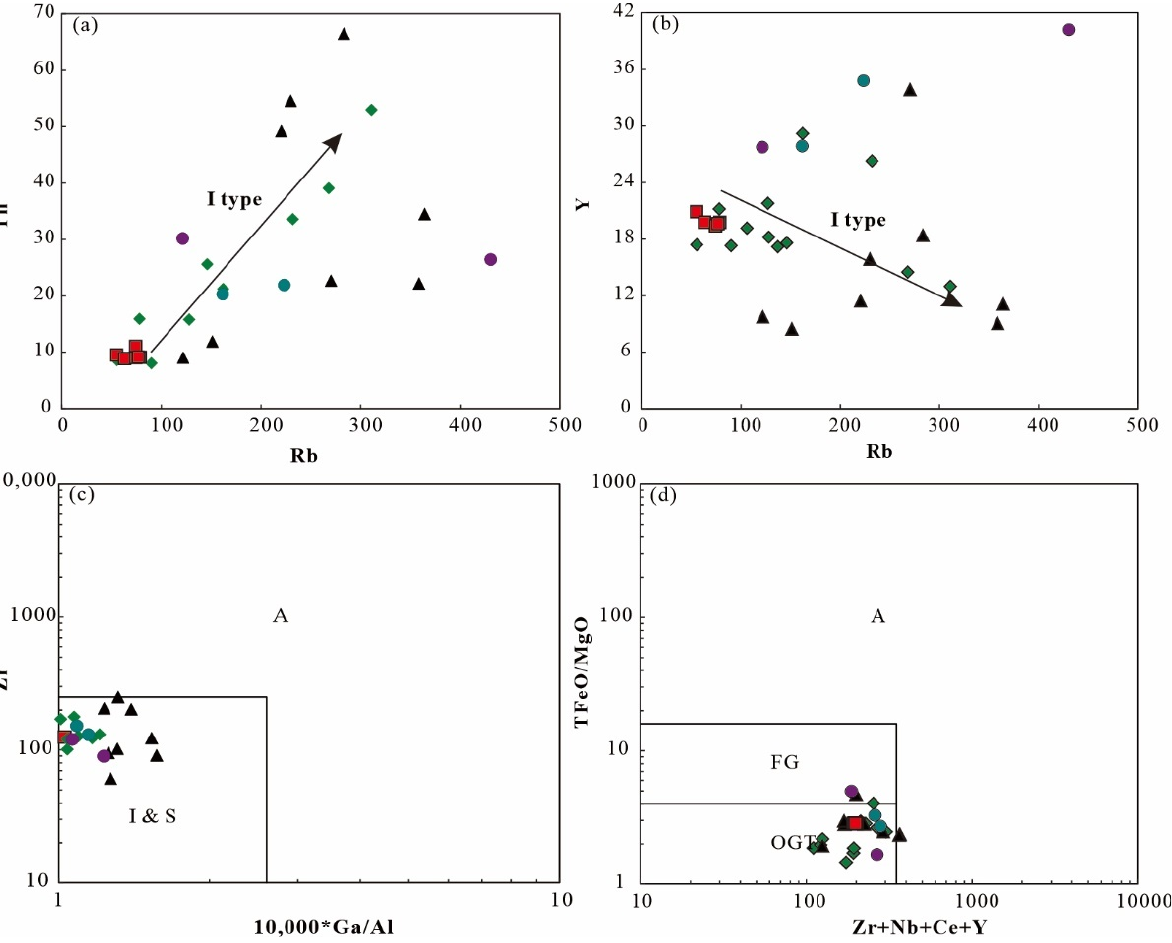
Figure 7. ( a ) P 2 O 5 vs. SiO 2 diagram; ( b ) Th vs. Rb diagram; ( c ) Y vs. Rb diagram; ( d ) TFeO/MgO vs. Zr+Nb+Ce+Y diagram [53].